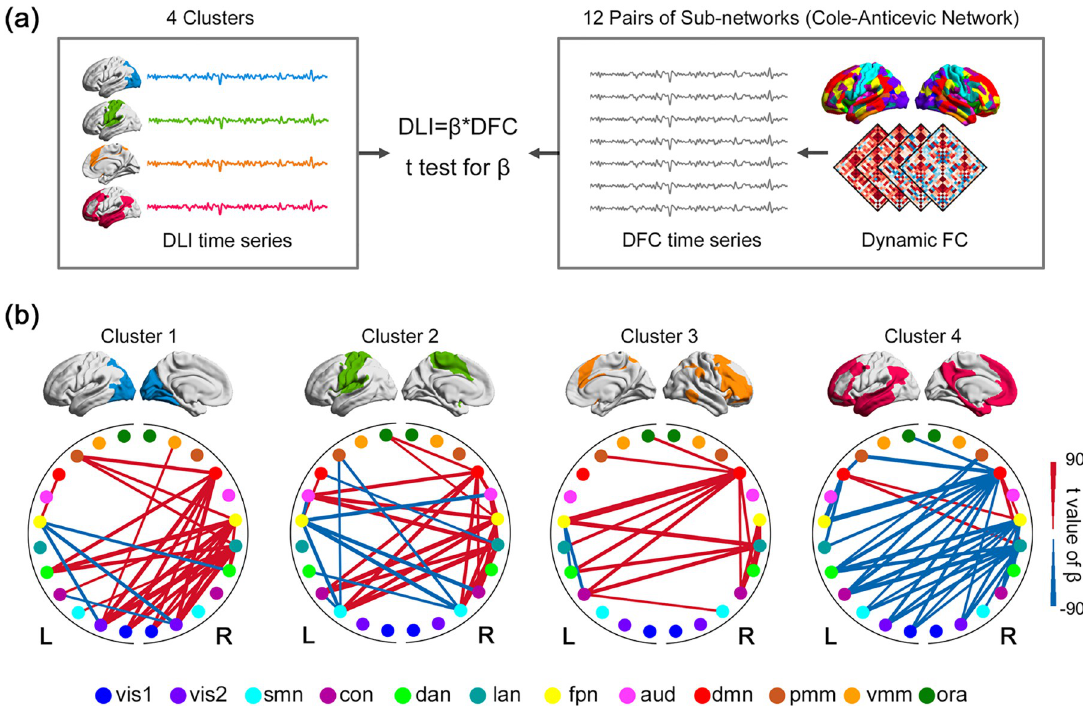
Fig 5. Association between dynamic laterality time series of the 4 identified clusters and the DFC within/between 24 subnetworks. (a) Analysis pipeline. We established linear regression models of cluster-level DLI time series on subnetwork-level DFC and performed one-sample t test on the regression coefficient ( β ) to investigate whether the influence of DFC on DLI was significantly greater than 0 (positive coupling) or less than 0 (negative coupling). (b) The association between dynamic laterality time series of Clusters 1/2/3/4 and the DFC within/between 24 subnetworks (according to CAB-NP). Only functional connectivity with very significant t -value of regression coefficient (with p < 1e-200 or |t| > 40, one-sample t test) is being shown since there are too many significant connections. Here, a positive laterality index indicates left lateralization. Colors of points indicate the network arrangement of the CAB-NP. L, left hemisphere; R, right hemisphere. The underlying data for this figure can be found in S4 Data. CAB-NP, Cole-Anticevic Brain-wide Network Partition; DFC, dynamic functional connectivity; DLI, dynamic laterality index; aud, Auditory network; con, Cingulo- Opercular network; dan, Dorsal-Attention network; dmn, Default Mode network; fpn, Frontoparietal network; lan, Language network; ora, Orbito-Affective; pmm, Posterior-Multimodal; smn, Somatomotor; Vis1, Visual1; vis2, Visual2; vmm,